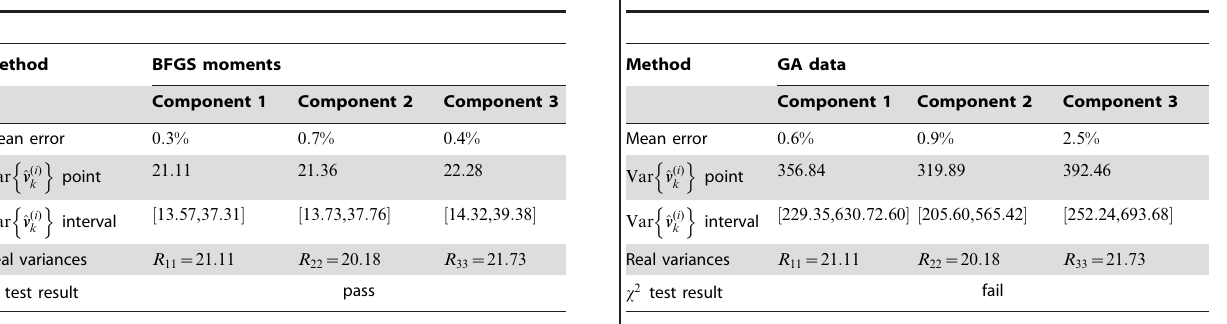
Table 5. x 2 test results for the estimation of 18 parameters in the repressilator model (moment matching).